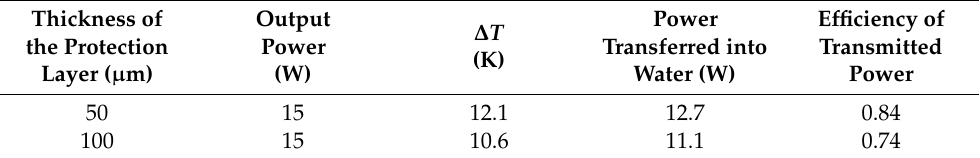
Table 3. The power setting, measured output power, difference of the water temperature in inlet and outlet, the calculated heat transferred into the water and the efficiency of the transmitted power depending on the thickness of the protection layer.